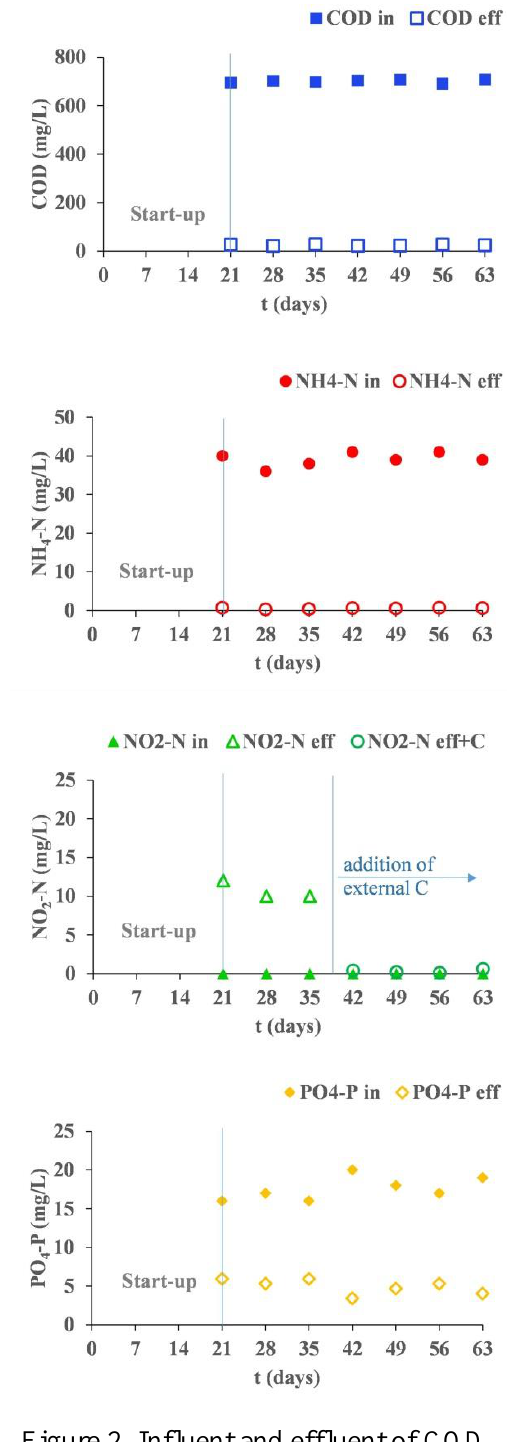
Figure 2. Influent and effluent of COD, NH -N, NO -N and PO -P during 4 2 4 biodegradation of fish canning wastewater at salinity 15 g NaCl/L in SBR with activated